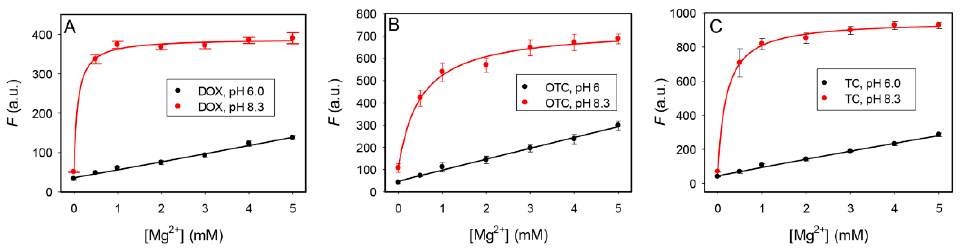
Figure 2. The fluorescence intensity at 530 nm of the tetracycline antibiotics at pH 6.0 and pH 8.3 in the presence of increasing concentration of Mg 2+ : ( A ) DOX, ( B ) OTC, and ( C ) TC.